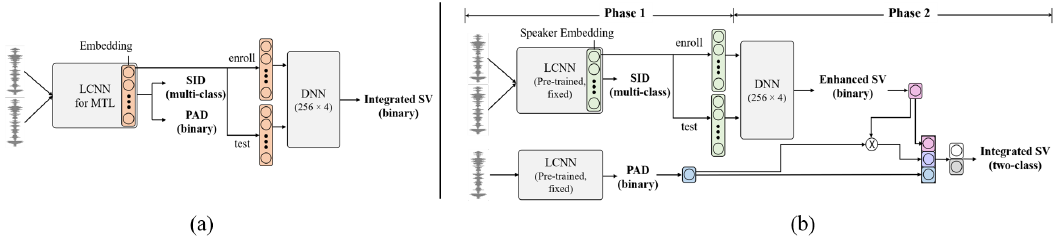
Figure 1. ( a ) An end-to-end architecture that trains embeddings (used for speaker identification (SID) and presentation attack detection (PAD)). LCNN and MTL refer to the light cnn and multi-task learning, concurrently; ( b ) a separate architecture that inputs speaker embeddings from SID and PAD results and outputs the Integrated result of speaker verification (SV) and